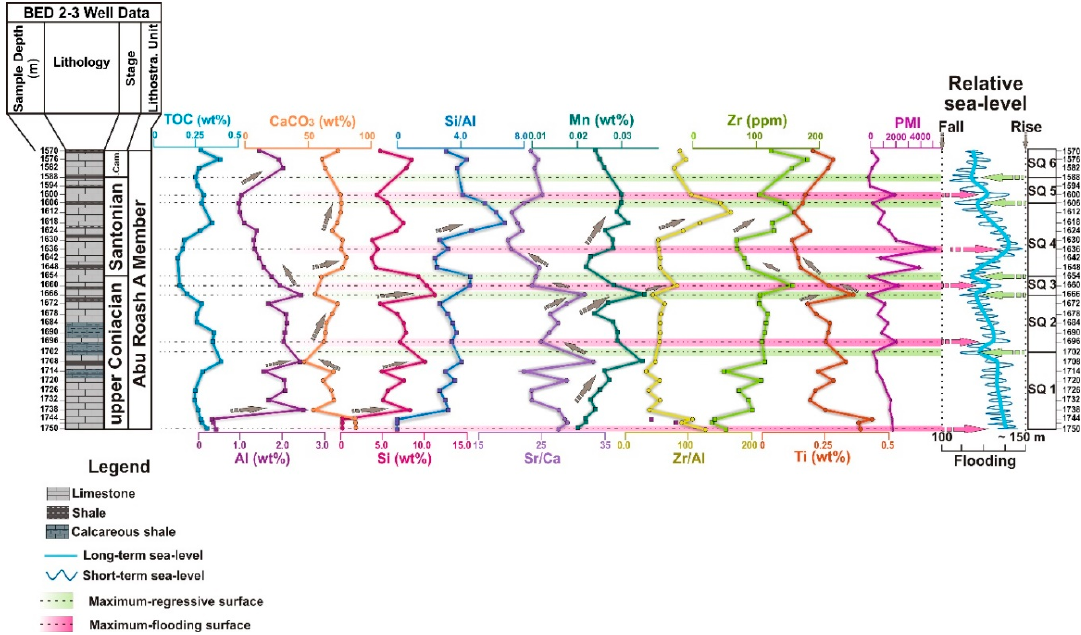
Figure 5. Chemostratigraphic distribution of TOC (wt.%), CaCO 3 , contents of various major and trace elements and ratios, and the palynological marine index (PMI) of the Abu Roash A Member used to construct major/minor transgressive-regressive trends of the relative sea level as well as bounding stratigraphic sequences.